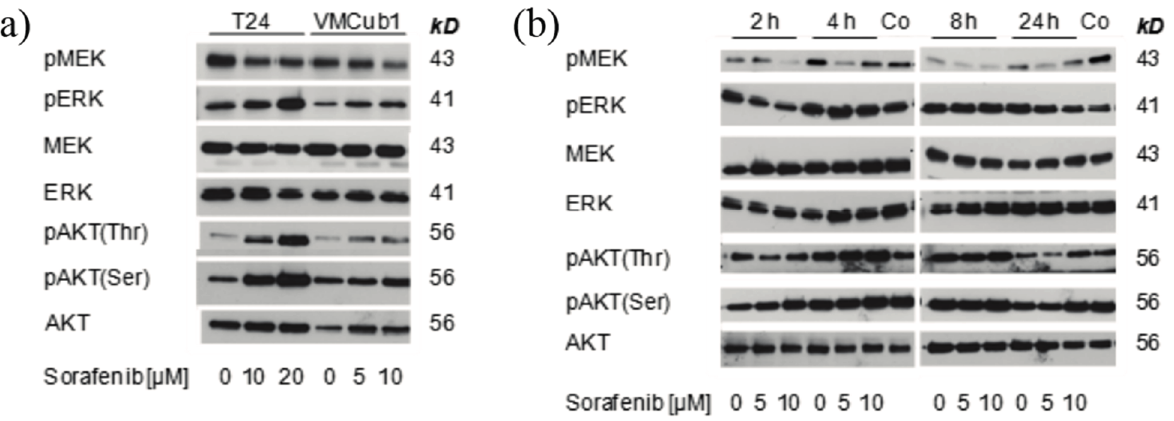
Figure 4. ( a ) Effect of sorafenib on phosphorylation of ERK, MEK and AKT in T24 and VMCub1 cell lines after 24 h treatment; and ( b ) Effect of sorafenib on phosphorylation of ERK, MEK and AKT in VMCub1 cells over time. The lanes marked “Co” contain extracts from T24 cells treated with 20 µM sorafenib for 24 h as positive controls. Note that the same extracts were analyzed on two different gels to avoid overlay by residual signals during the analysis of